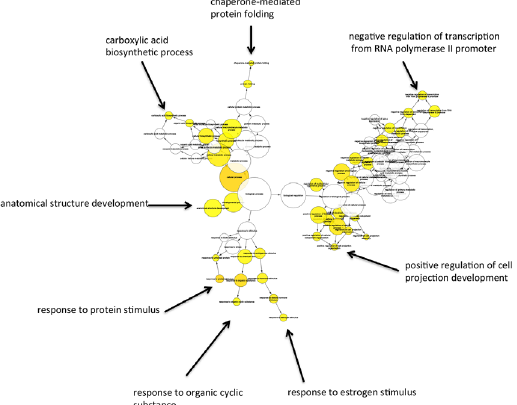
Fig 3. Network of gene ontology terms significantly ( P < 0.05) associated with the genes that were upregulated after hypoxia. Note that the highest order ontology terms (e.g., glucocorticoid signaling, or prostaglandin biosynthesis, etc) are in the outermost region of the network, while more basic ontology terms (e.g., “ biological process ” , which is not clearly shown in this figure because of reduced size of the node labels) are in the center of the network. The intensity of the color of each node denotes statistical significance ( i . e ., orange greater statistical significance than yellow, and uncolored nodes are not statistically significant). All nodes labeled with arrows are statistically significant.